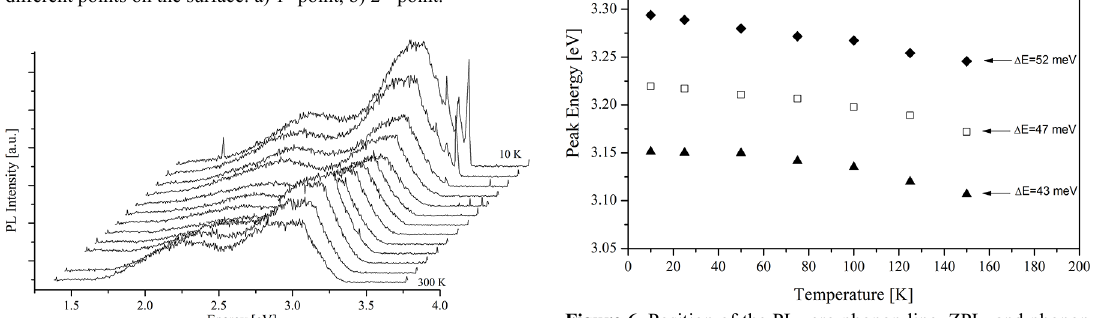
Figure 3. Room temperature PL spectra of a GaN film taken at two different points on the surface: a) 1 st point, b) 2 nd point.